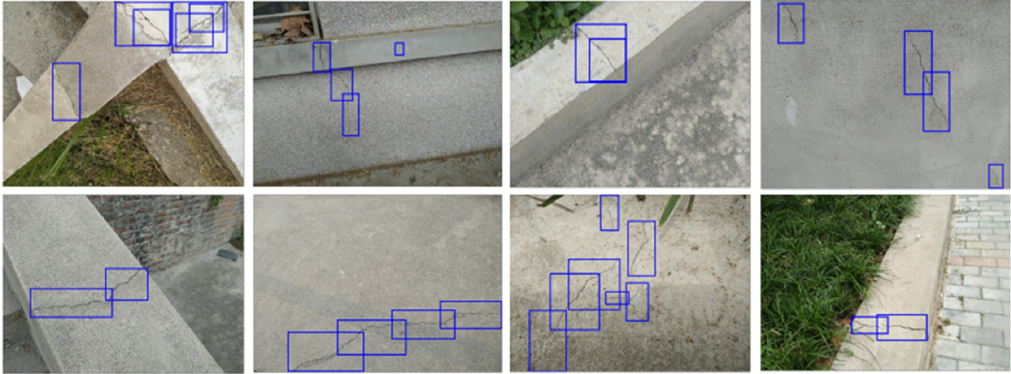
Figure 5. Crack images with their marks.